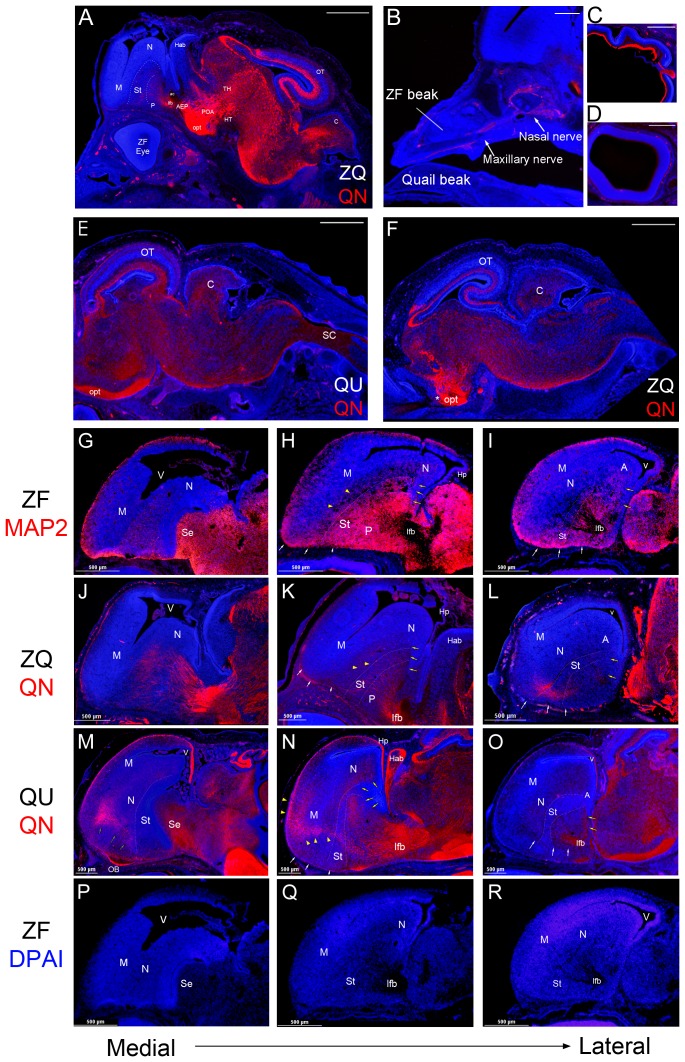
Quail neuronal fibers project into quail hindbrain and zebra finch forebrain.Neuronal fibers are stained with QN or MAP2 antibodies (red) and the cell bodies are stained with DAPI (blue). (A) General distribution of quail neuronal QN stained fibers in a ZQ chimera at ED9. Scale bar = 1 mm. (B) The quail neurons innervate the peripheral tissue of the zebra finch head graft. (C–D) Quail optic ganglion neuron fibers in quail (C), but not in zebra finch retina of chimeras (D). (E–F) Distribution of quail neuronal fibers in quail brainstem (E) is similar to the distribution in chimeras (F) at ED9. However, the optic fibers from zebra finch graft eyes (*) are not stained by QN in chimeras. (G–I) Neuronal fibers patterns of forebrain stained by MAP2 in zebra finch. (J–L) Stained by QN in chimeras. (M–O) Stained by QN in quails. (P–R) Stained by QN in zebra finches. Each column shows a similar section level from medial (left) to lateral (right). The fiber staining of all brain sections shows two similar tracts from pallidum to caudal nidopallium (yellow arrows) and to anterior ventral mesopallium (white arrows) in zebra finch (H–I), chimera (K–L) and quail (N–O). In quail brain sections (M–N), the neuronal fiber tract (yellow arrowheads) is from pallidum through nidopallium to anterior dorsal mesopallium. The QN fibers were strongly stained in the quail hippocampus (N), not in the chimera (K). In chimera (K) and zebra finch (H) sections, the neuronal fiber tract (yellow arrowheads) only extends to the nidopallium. (P–R) The zebra finch forebrain did not stain with the QN antibody, as expected. Scale bar = 1 mm in A, C, and D; 500 µm in B and D.